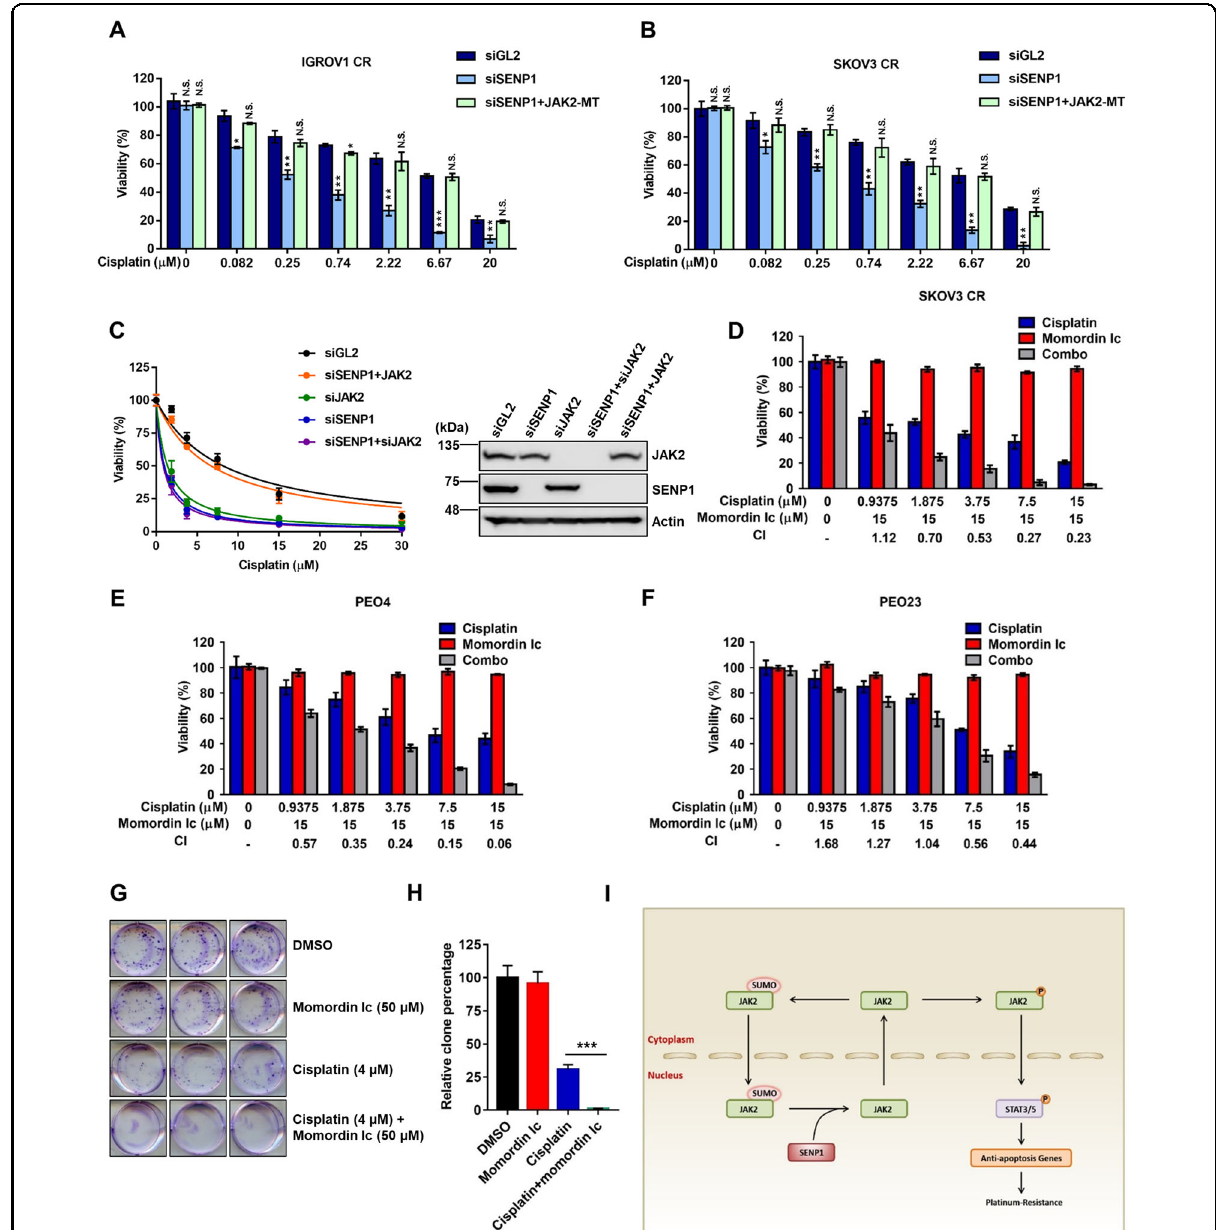
Fig. 7 SENP1 is a potential target for overcoming cisplatin resistance. A Cell viability of IGROV1 CR treated with indicated siRNAs and JAK2. Data are represented as mean ± SD ( n = 3). N.S., not signi fi cant; *, p < 0.05; **, p < 0.01; ***, p < 0.001. B SKOV3 CR cells treated with indicated siRNAs and JAK2. Data are represented as mean ± SD ( n = 3). N.S., not signi fi cant; *, p < 0.05 ; **, p < 0.01. siSENP1 + JAK2-MT, ectopic expression of His-JAK2- SUMO mutant in SENP1 knocked down cells. C Ectopic expression of JAK2 restores cisplatin resistance in SENP1 depleted cells. IGROV1 CR cells treated with indicated siRNAs were transfected with vector JAK2 plasmids. Cell viability was analyzed by using cell viability assay as described in “ Materials and Methods ” . Right, the expression of indicated proteins in cells treated in ( C ). D The synergistic effects of cisplatin and Momordin Ic in SKOV3 CR, ( E ). PEO4 and ( F ). PEO23 cells. Concentrations of cisplatin and Momordin Ic as well as the CI index were indicated. Data are represented as mean ± SD ( n = 3). G Representative colony formation and ( H ) quanti fi cation of IGROV1 CR cells treated with cisplatin and Momordin Ic. Colonies were stained with crystal violet. Data are represented as mean ± SD ( n = 3). ***, p < 0.001. I Working model of SENP1-mediated deSUMOylation of JAK2 regulates its kinase activity and platinum drug